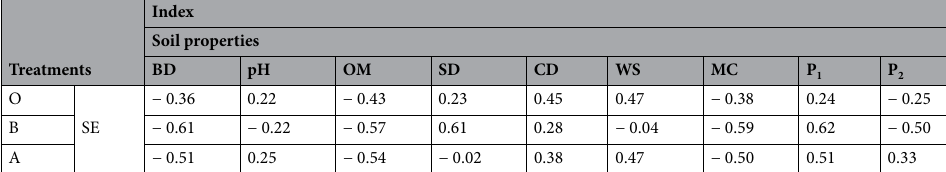
Table 6. Analysis of Correlation between sheet erosion rate and soil properties of three treatments. The significance level of the equation in the table is 0.05. BD is soil bulk density(g/cm 3 ), OM is organic matter(g/ kg), SD is soil particle density(g/cm 3 ), CD is electrical conductivity(ds/m), WS is water-soluble salt content(g/ kg), MC is microbial carbon(mg/kg), P 1 is > 2 mm soil particle content(%), P 2 is < 0.002 mm soil Particle content(%). O is bare slope, B is Prunella vulgaris combined with earthworm planting slope, A is Single planting prunella vulgaris